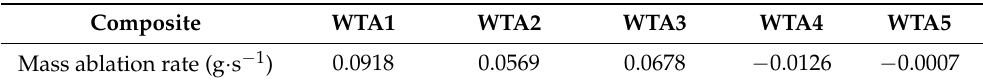
Table 3. Mass ablation rates of the W-TaC composites.